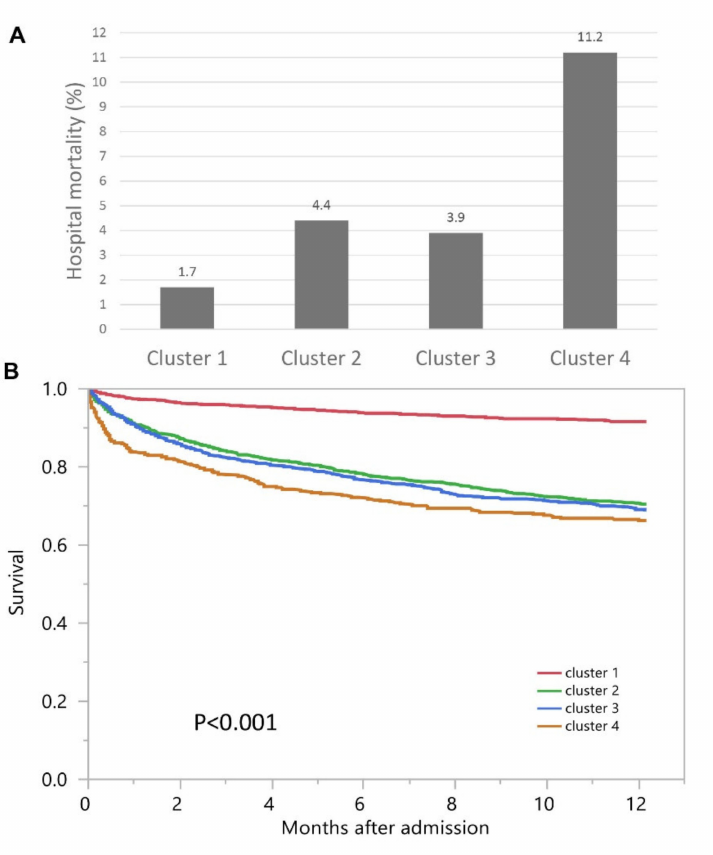
Figure 4. ( A ) Hospital mortality among different clusters with admission AKI; ( B ) One-year mortality among different clusters with admission